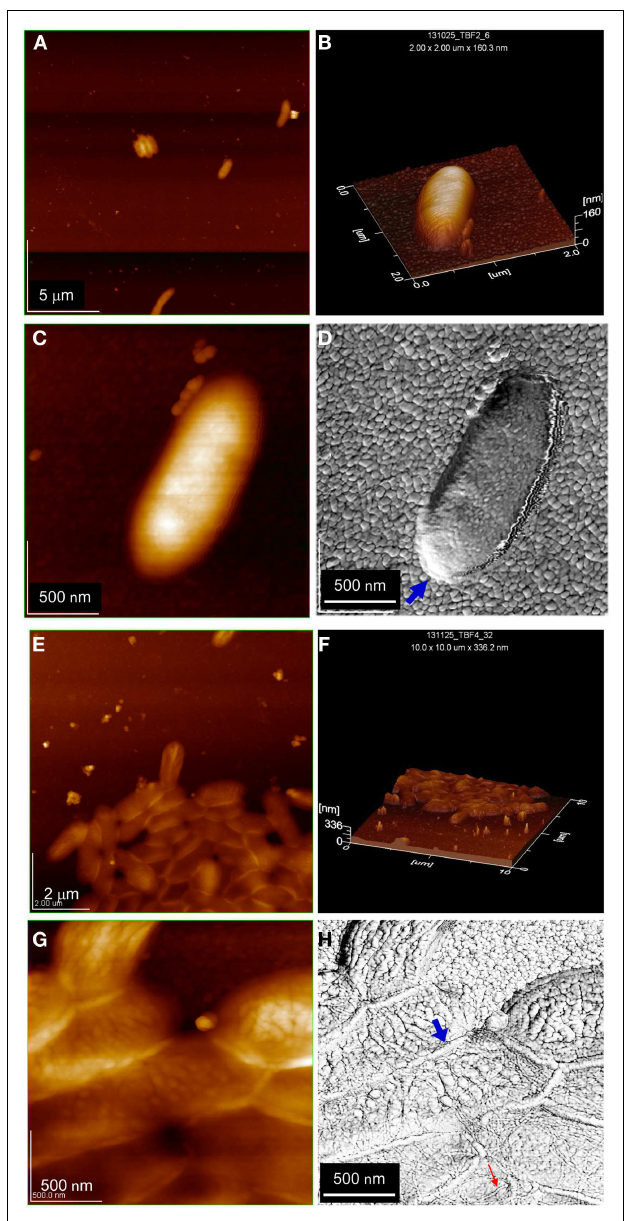
FIGURE 2 |AFM images of lag phase biofilm depicted in Figure 1 . (A) Topographical image of individual cells and a small cluster at low resolution. (B) Three-dimensional topographical image of an individual cell. (C,D) Topographical and corresponding phase image of an individual cell at high resolution. (E,F) Topographical image and three-dimensional topographical image of larger cell cluster at low resolution. (G,H) Topographical and corresponding phase image of larger cell cluster at high resolution. Small red arrows in (H) point to example linear structures (many more can be seen in the image). Large blue arrows in (D,H) point to outer cell membrane.